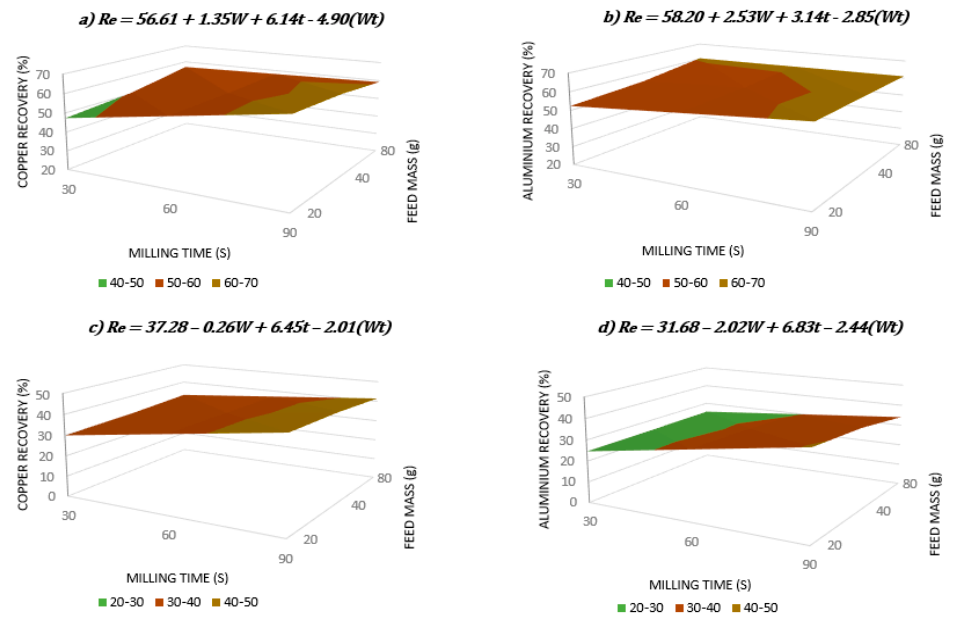
Figure 16. Surface plots of the metal recovery in the product size − 0.125 mm after hammer milling as a function of feed mass and milling time: ( a ) Cu-Feed particle size fraction was 1–2 mm; ( b ) Al-Feed particle size fraction was 1–2 mm; ( c ) Cu-Feed particle size fraction was 2–4 mm; ( d ) Al-Feed particle size fraction was 2–4 mm.